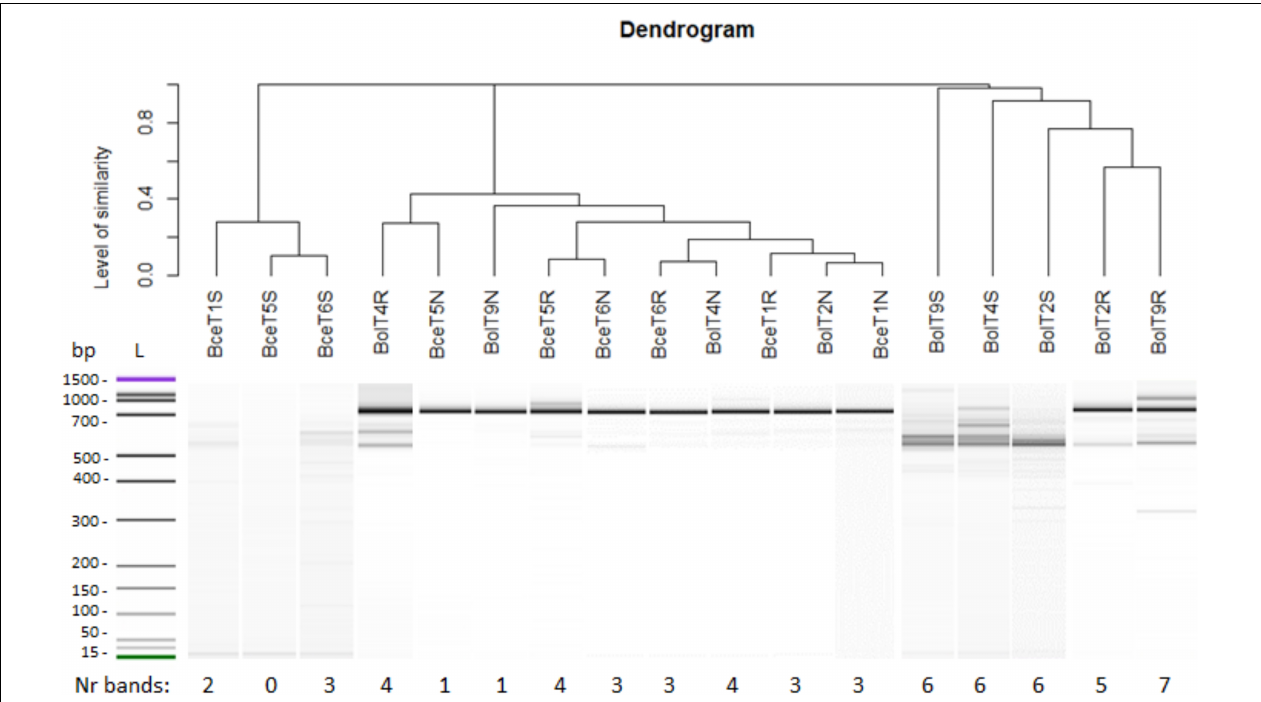
FIGURE 6 | Genetic diversity of arbuscular mycorrhizal fungi (AMF) isolated from samples of soil (S), roots (R), and nodules (N) of T. repens from the metal-polluted waste heap (Bol) and the non-polluted reference area